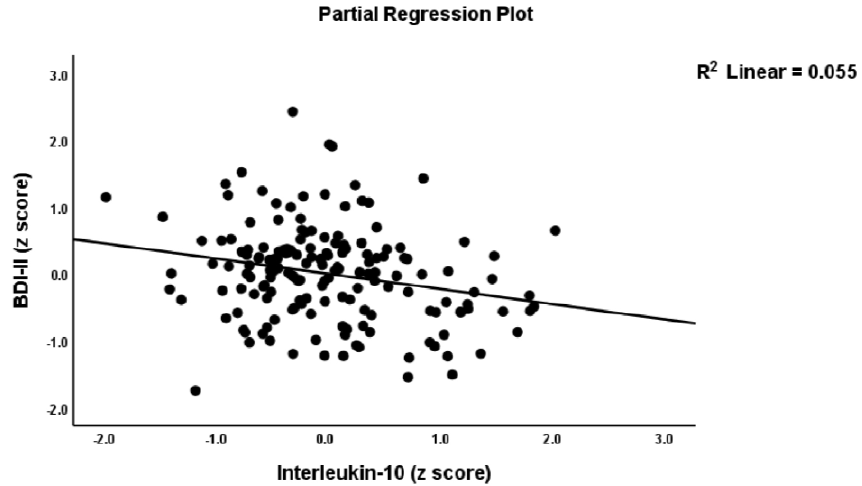
Figure 2. Partial regression plot of the total Depression Inventory (BDI-II) score on the tender joint count .